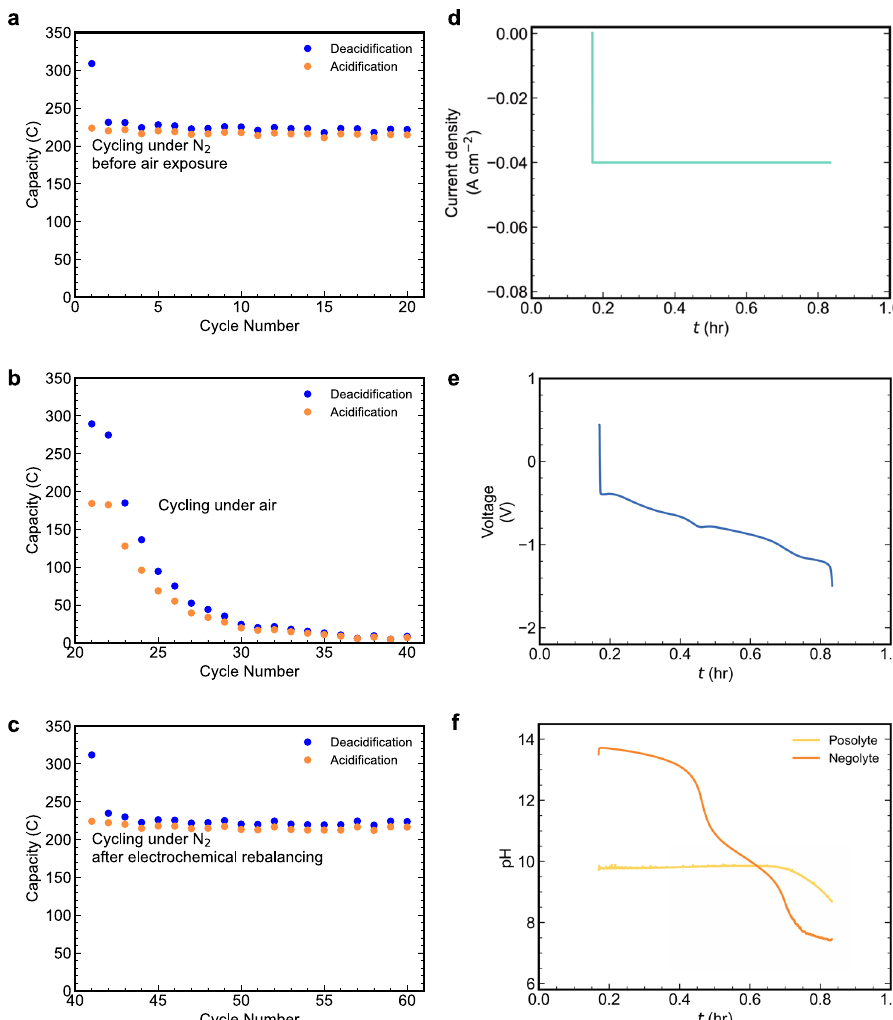
Fig. 6 The capacity fade caused by O 2 on Fe(CN)6|DSPZ cell cycling (a – c) and its mitigation by the electrochemical rebalancing method (d – f). a Charge capacity vs. cycle number of the cell under pure N 2 atmosphere. The fi rst cycle has much higher deacidi fi cation capacity due to residual oxygen. b Charge capacity vs. cycle number of the same cell from ( a ) under air. Capacity fades quickly because of the depletion of K 4 Fe(CN) 6 in the posolyte. c Charge capacity vs . cycle number of the cell from ( b ) under pure N 2 atmosphere, after the electrochemical rebalancing step. The fi rst cycle has much higher deacidi fi cation capacity due to residual oxygen. d Current density, ( e ) voltage, ( f ) posolyte and negolyte pH during the electrochemical rebalancing